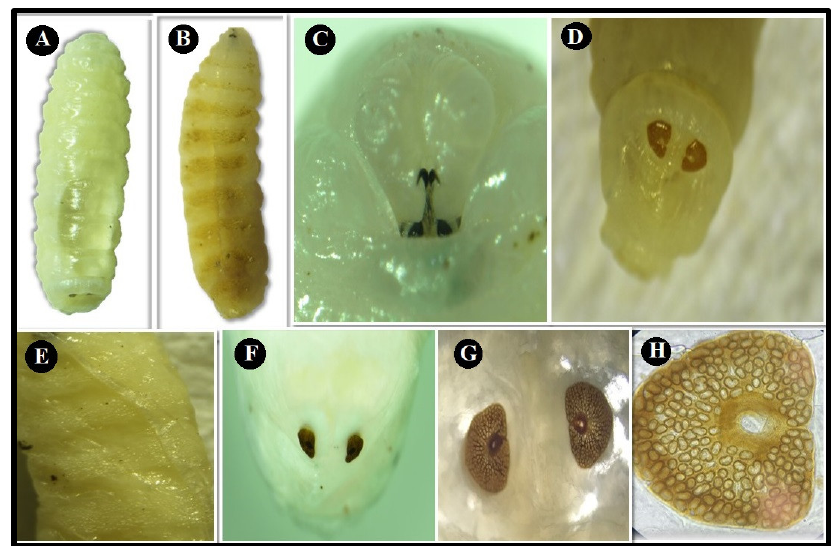
Figure 3. Second instar larva (L2). ( A ) Dorsal view; ( B ) ventral view; ( C ) the front end containing the cephaloskeleton ; ( D ) the median part of the postanal bulge is spinulose; ( E ) ventral view shows spines on anterior segment ; ( F ) posterior spiracle; ( G ) stigmal plates and channel appear with clear distinct suture; ( H ) posterior spiracle (10×). Third instar larvae (L3) are yellow in color when young (Figure 4A), changing to a light brown later in the mature stage, and show broad transverse blackish bands on the dorsal side (Figure 4B). The second segment on the dorsal side presents with a variable number of small denticles; the following segments are bare but have a rough, leatherlike skin pattern, which is distinct only on the darkened parts. On the ventral side, the seg- ments bear rows of strong spines (Figure 4C), which are irregularly placed on the third segment but are fairly regular on the following ones. The number of rows varies from two to five (Figure 4D). The postanal bulge shows fewer spines, while the preanal bulge is bare (Figure 4E). The posterior peritremes are circular, with a central button and lacking a dis- tinct suture and the channel appears in the posterior peritremes (Figure 4 F ).